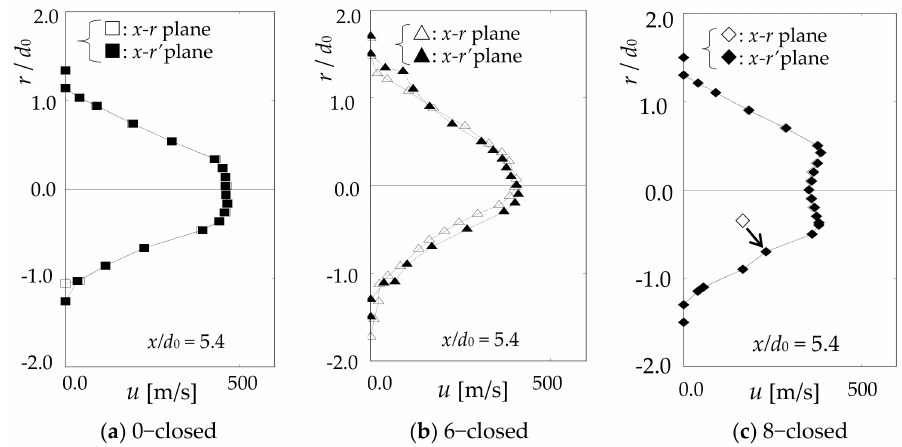
Figure 8. Cross sectional velocity distribution at x / d 0 = 5.4 ( P 0 = 0.38 MPa): The velocity profile of the 6 − closed nozzle is asymmetric because the jet deflects and reattaches to the side wall of the